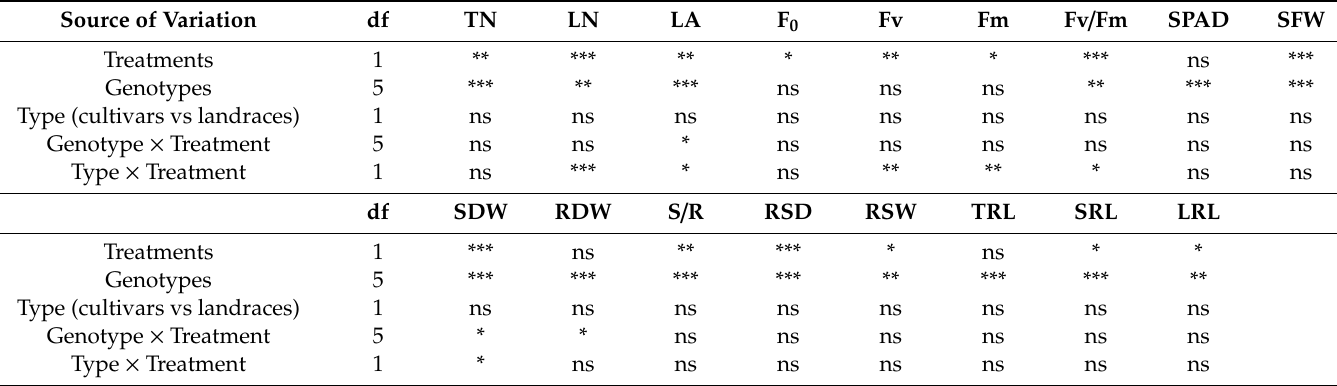
Table 1. Analyses of variance of traits measured in six barley genotypes, under control and drought conditions in rhizoboxes, at the end of the four weeks’ experiment. Source of Variation df TN LN LA F 0 Fv Fm Fv / Fm SPAD SFW Treatments 1 ** *** ** * ** * *** ns *** Genotypes 5 *** ** *** ns ns ns ** *** *** Type (cultivars vs landraces) 1 ns ns ns ns ns ns ns ns ns Genotype × Treatment 5 ns ns * ns ns ns ns ns ns Type × Treatment 1 ns *** * ns ** ** * ns ns df SDW RDW S / R RSD RSW TRL SRL LRL Treatments 1 *** ns ** *** * ns * * Genotypes 5 *** *** *** *** ** *** *** ** Type (cultivars vs landraces) 1 ns ns ns ns ns ns ns ns Genotype × Treatment 5 * * ns ns ns ns ns ns Type × Treatment 1 * ns ns ns ns ns ns